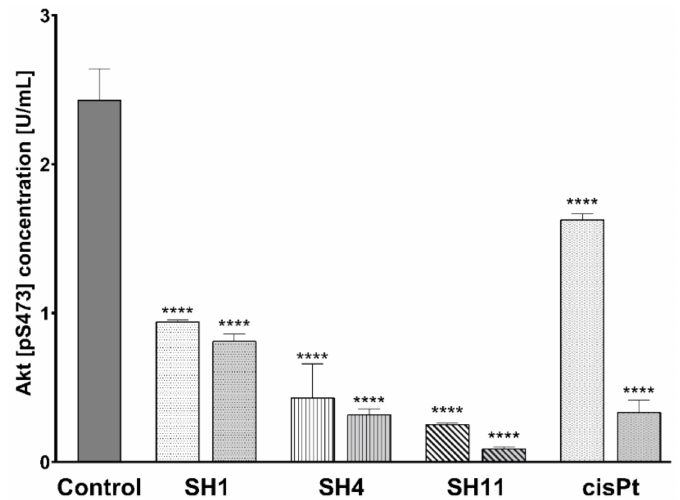
Figure 6. Concentrations of Akt [pS473] in MCF-7 human breast cancer cells after 24-h incubation with SH1 and SH4 at concentrations of 600 µ g/mL and 800 µ g/mL, SH11 at 200 µ g/mL and 400 µ g/mL, and cisPt at 50 µ M and 100 µ M. Results are presented as mean ± SD from three experiments performed in duplicate. Statistical significance was calculated using one-way ANOVA with Bonferroni multiple comparison test. Differences were considered statistically significant at **** ( p ≤ 0.0001).